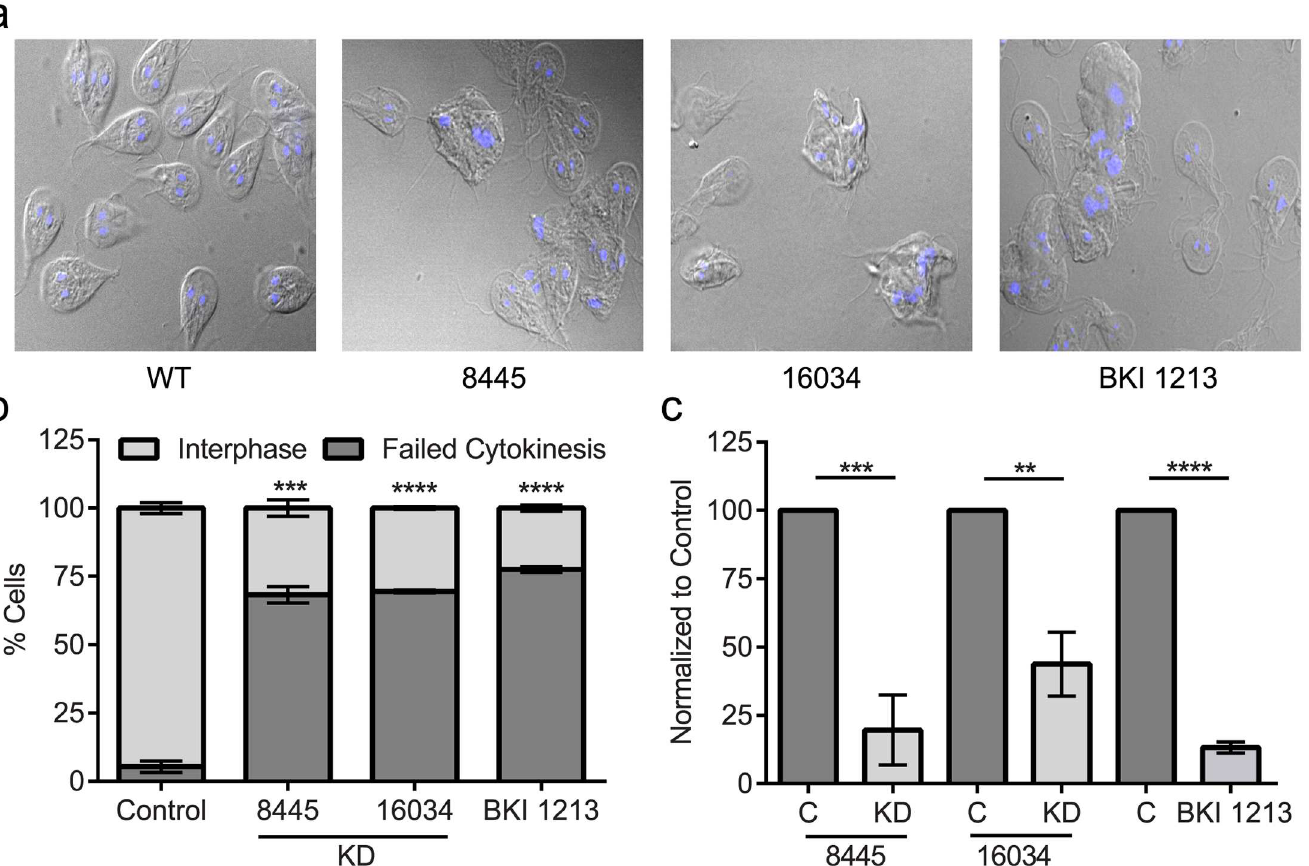
Fig 8. BKI 1213 mimics defects observed in knockdown of kinases Gl50803_ 8445 and Gl50803_16034. a) Fluorescent microscopy images of cells 48 hours after morpholino knockdownor treatment with BKI 1213 demonstrate a defect in cytokinesis compared to wild type control cells; cells complete nuclear division but not cytokinesis. b) Quantification of percent of cells that failed to complete cytokinesis. In each treatment, more than 67% of cells were stuck in cytokinesis; 68% of Gl50803_8445, 69.5% of Gl50803_16034and 77.5% of cells treated with BKI 1213 were unableto complete cytokinesis. c) Attachment assays confirmed that when protein is depletedor cells are treated with BKI 1213, the ability for cells to attach is greatly reduced. Less than 20% of kinase 50803_8445 cells were able to maintain attachment, 43.8% of kinase 50803_16034 cells were able to maintain attachment and only 13% of cells treated with 5 μ M BKI 1213 maintainedattachment. Experiments were replicateda minimum of three times and significance was evaluatedby t-test, ** = p < 0.01, *** = p < 0.001, **** = p <